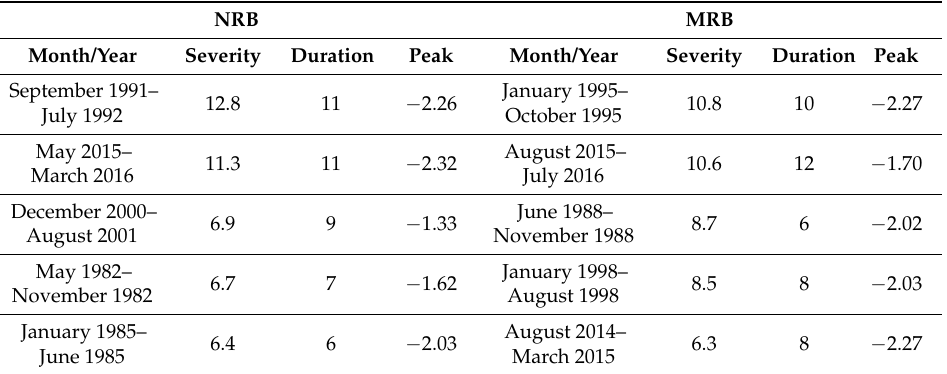
Table 4. Top five most severe dry episodes occurring in the NRB and MRB according to SPEI1 and their duration and peak. Period: